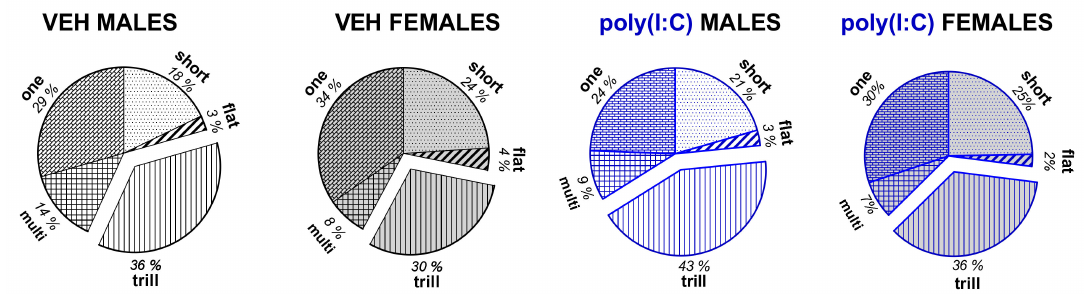
Figure 3. Poly(I:C) changed the percentage distribution of call categories within the tested groups. There was a significant overall difference between vehicle- and poly(I:C)-exposed animals in the distribution of trill calls ( p < 0.05, Newman–Keuls post hoc test following a significant treatment × call category interaction).